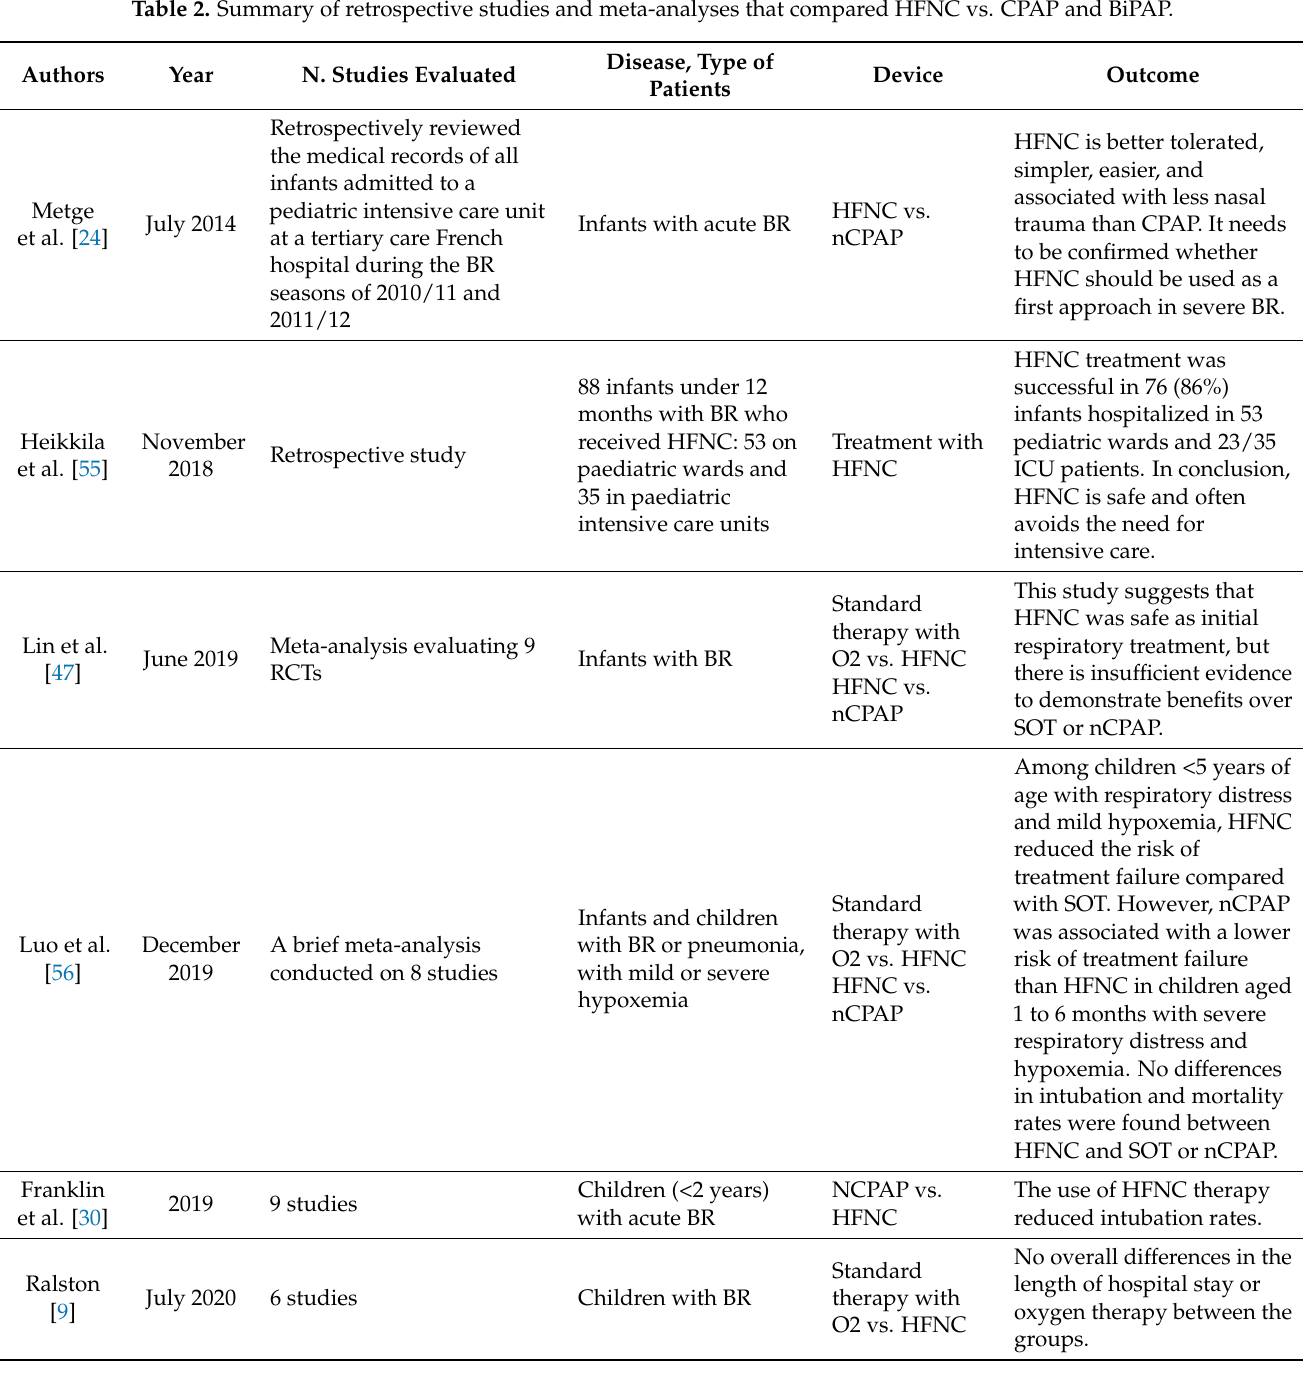
Table 2. Summary of retrospective studies and meta-analyses that compared HFNC vs. CPAP and